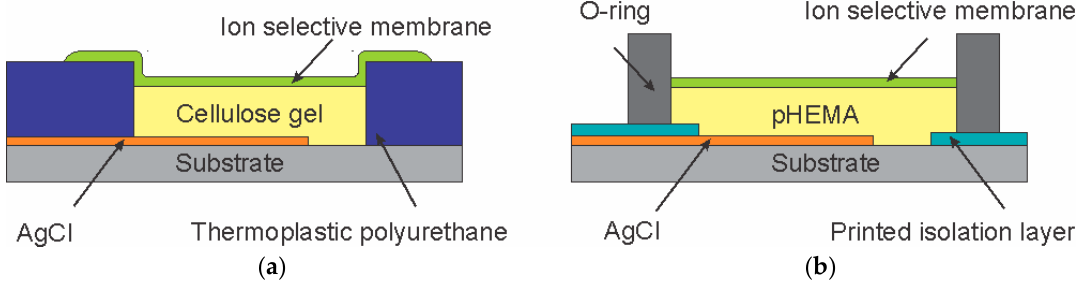
Figure 3. ( a ) Illustration of cross section of a new ion-selective electrode with an internal electrolyte layer of cellulose gel casted in a reservoir formed by a thermoplastic polyurethane layer; ( b ) Illustration of the previously reported ion-selective electrode with hydrogel pHEMA [3] is shown for